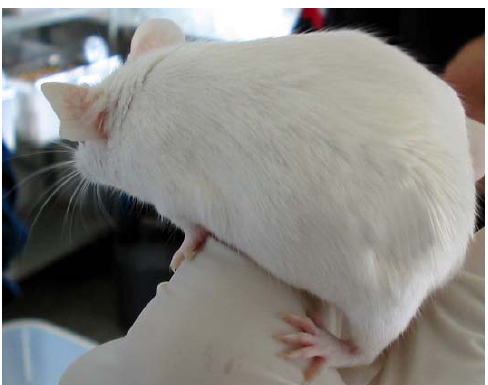
Figure 5: Absence of necrosis at the inoculation site for irradiated bothropic venom, one week after